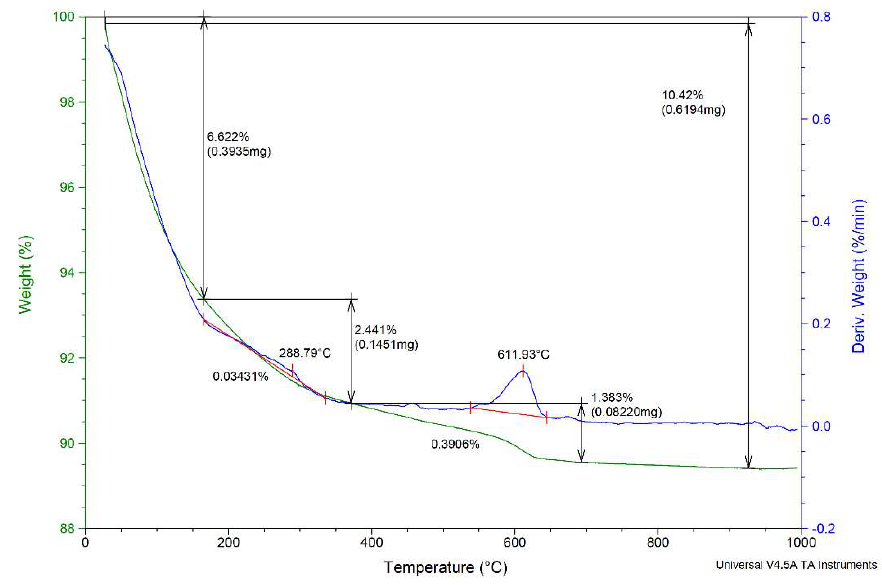
Figure 3. The TGA/DTG analysis of the NZ1 zeolite sample .